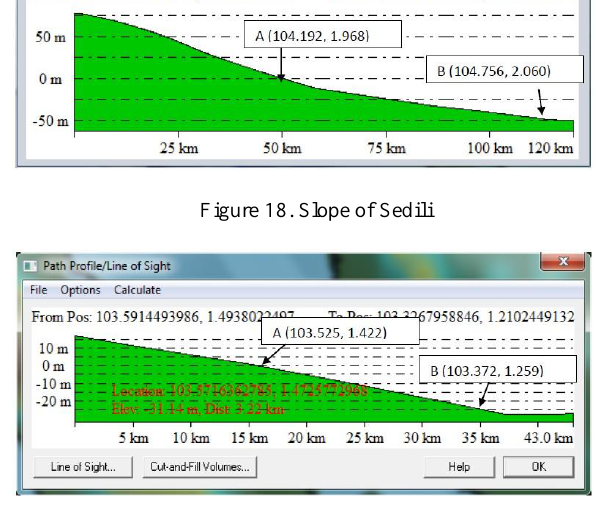
Figure 19. Slope of Kukup